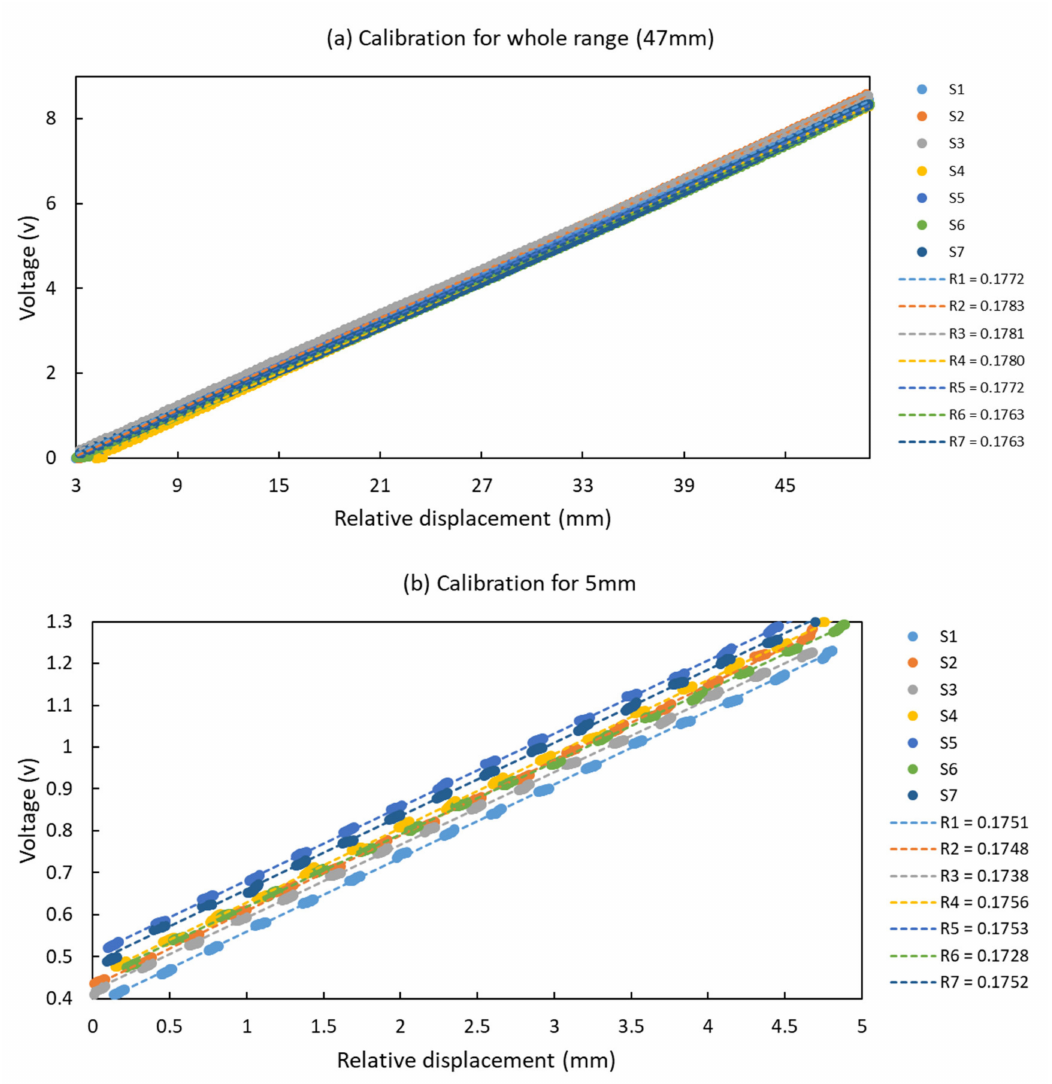
Figure 4. Calibration of seven sensors in terms of relative displacement (slip) and voltage; S1 to S7 are measured data, and R1, to R7 denote calibration coefficients for sensors numbers 1 to